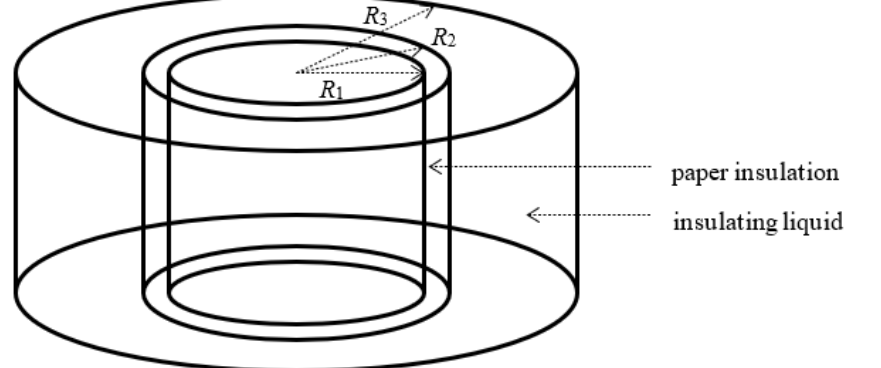
Figure 1. Transformer insulation model, R 1 —cylinder radius reflecting windings and core, R 2 − R 1 = paper insulation thickness, R 3 − R 2 = space filled with electrical insulating liquid.